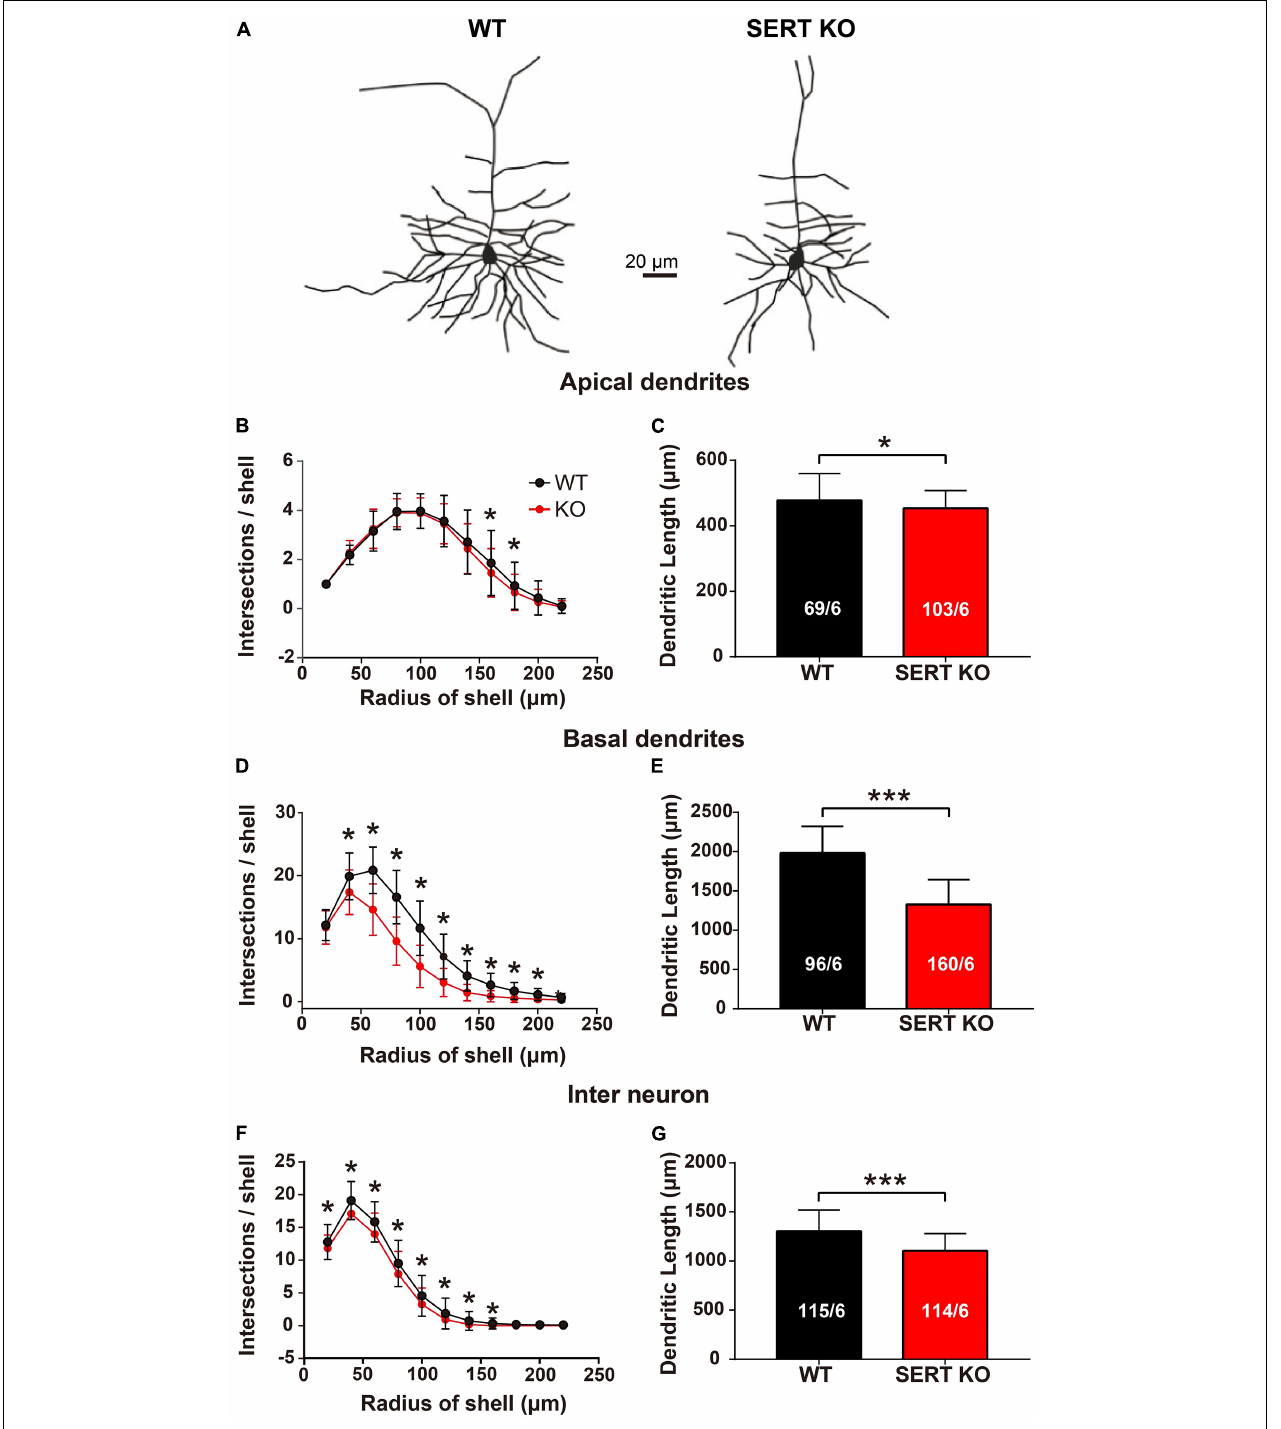
FIGURE 2 | Serotonin transporter (SERT) knockout (KO) degrades the dendrites of layer IV pyramidal neurons and layer II/III interneurons in auditory cortex. (A) Representative dendritic morphology of layer IV pyramidal cells in auditory cortex from wild-type (WT) and SERT KO mice. Scale bar: 20 µ m. (B,C) Comparing the number of intersections and the total length of the apical dendrites of layer IV pyramidal cells in WT mice with SERT KO mice. (D,E) Comparing the number of intersections and the total length of the basal dendrites of layer IV pyramidal cells in WT mice with SERT KO mice. (F,G) The number of intersections and the total length of the dendrites of layer II/III interneurons were significantly reduced in SERT KO mice, compared with WT mice. The number of intersections of dendrites was measured with 20- µ m concentric spheres centered on the soma by Sholl’s analysis. The numbers in the column indicate the numbers of neurons/numbers of animals analyzed. Data are presented as means ± SD. * p < 0.05; *** p < 0.001, Student’s t -tests and two-way ANOVA.